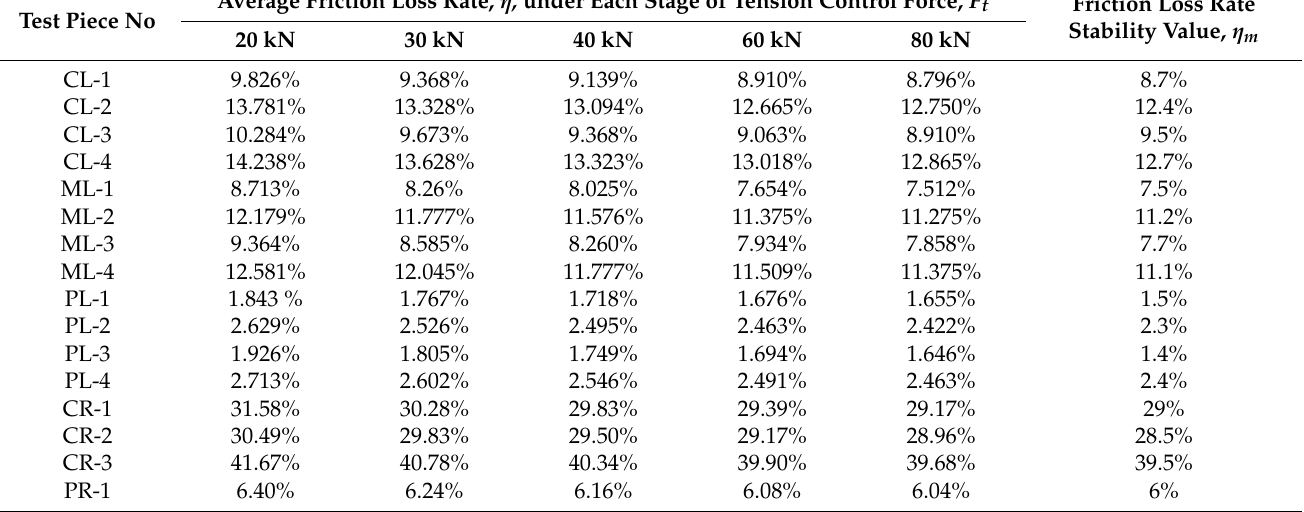
Table 4. Summary of the processed experimental